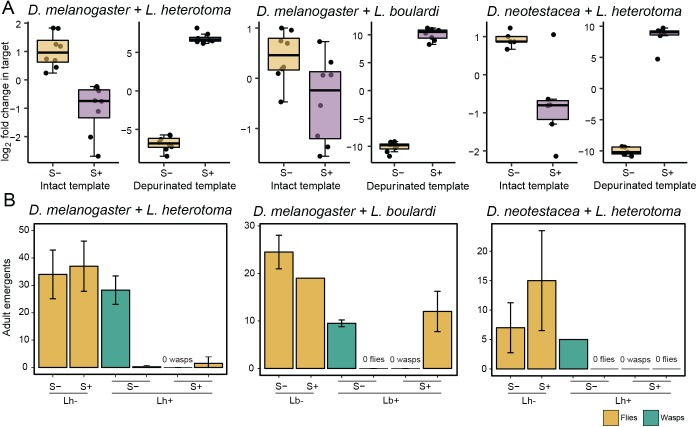
Parasitic wasp ribosomes are depurinated during host protection.Levels of intact and depurinated wasp ribosomes are significantly decreased and increased, respectively, in Spiroplasma-positive flies, compared to Spiroplasma-negative flies (A). Results of t-tests for intact ribosomes: D. melanogaster + L. heterotoma, p < 0.001; D. melanogaster + L. boulardi, p = 0.028; D. neotestacea + L. heterotoma, p = 0.010, and for depurinated ribosomes, all fly-wasp pairs, p < 0.001; n = 8, 8, 6, and 5 flies per treatment, for D. melanogaster S+, S-, and D. neotestacea S+, S-, respectively. Jitter points are the mean of two technical replicates per wasp-infested larva. Outcomes of wasp exposure for fly and wasp survival were measured as emerged adults (B). Each strain of Spiroplasma kills Leptopilina. L. heterotoma and L. boulardi emergence is significantly reduced in Spiroplasma-positive flies relative to Spiroplasma-negative controls (t-tests, L. heterotoma in D. melanogaster, p < .001; L. boulardi in D. melanogaster, p = .003; L. heterotoma in D. neotestacea, p < .001). Y-axes are labeled with total number of adult emergents per dish and error bars show the standard deviation of the mean number of adult emergents across replicate dishes (sample sizes: L. heterotoma in D. melanogaster, 60 larvae, 4 dishes; L. boulardi in D. melanogaster, 40 larvae, 2 dishes; L. heterotoma in D. neotestacea, 40 larvae, 2 vials).